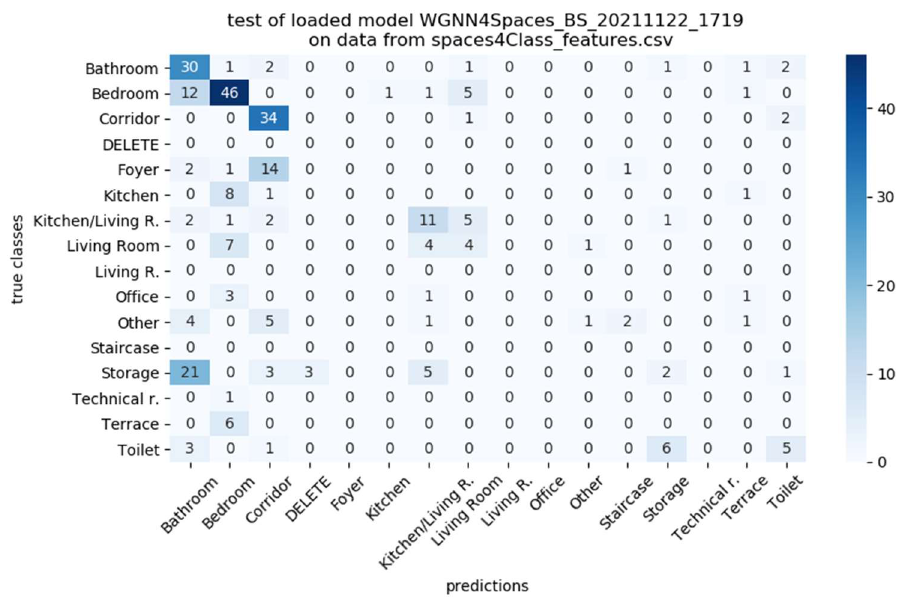
Figure 4. ( a ) An IFC model visualized with BIMVision software (https://bimvision.eu/, accessed on 15 January 2022). ( b ) The output of our WGCN space classifier for the spaces on the two floors of the building model.